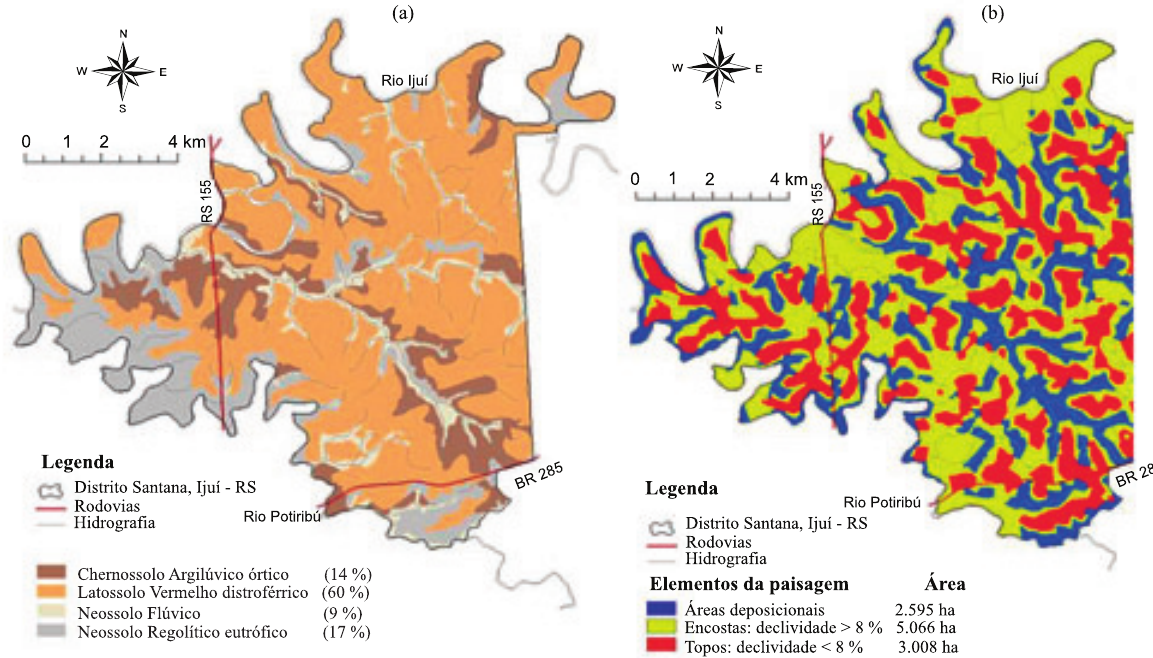
Figura 2. (a) Mapa de solos compilado de abrão & azolin (1970) e (b) mapa da distribuição dos elementos da paisagem do distrito santana, ijuí -